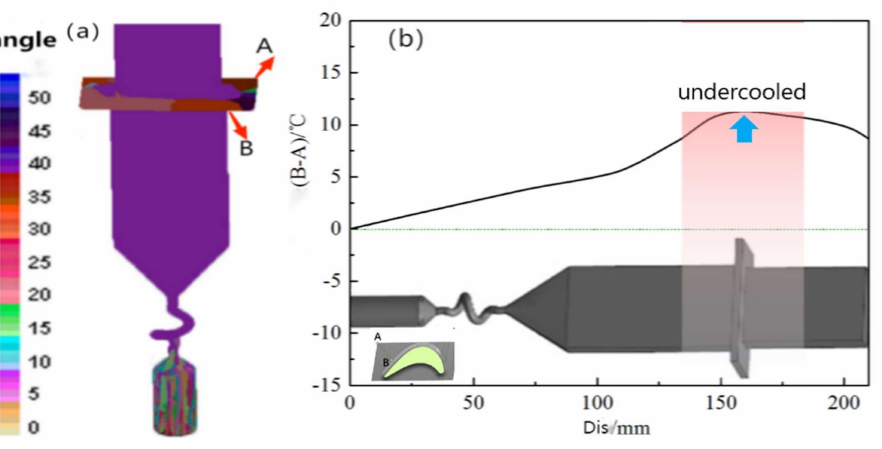
Figure 6. ( a ) Simulation results of the CAFE grain structure. ( b ) Temperature difference of B–A